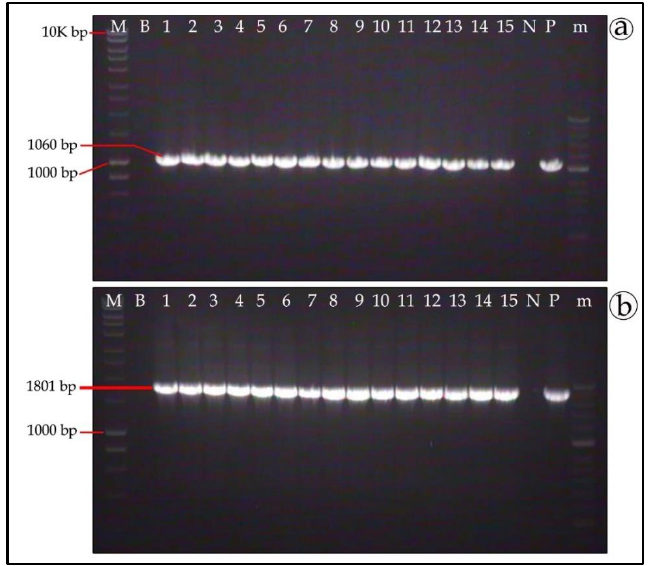
Figure 5. PCR verification of the T. boudieri transformed clones. Genomic DNA was extracted from the antibiotics-resistant mycelia of T. boudieri transformants. PCR amplification of green fluorescent protein ( a ) and red fluorescent protein ( b ) yielded fragments of 1060 bp and 1801 bp, respectively.